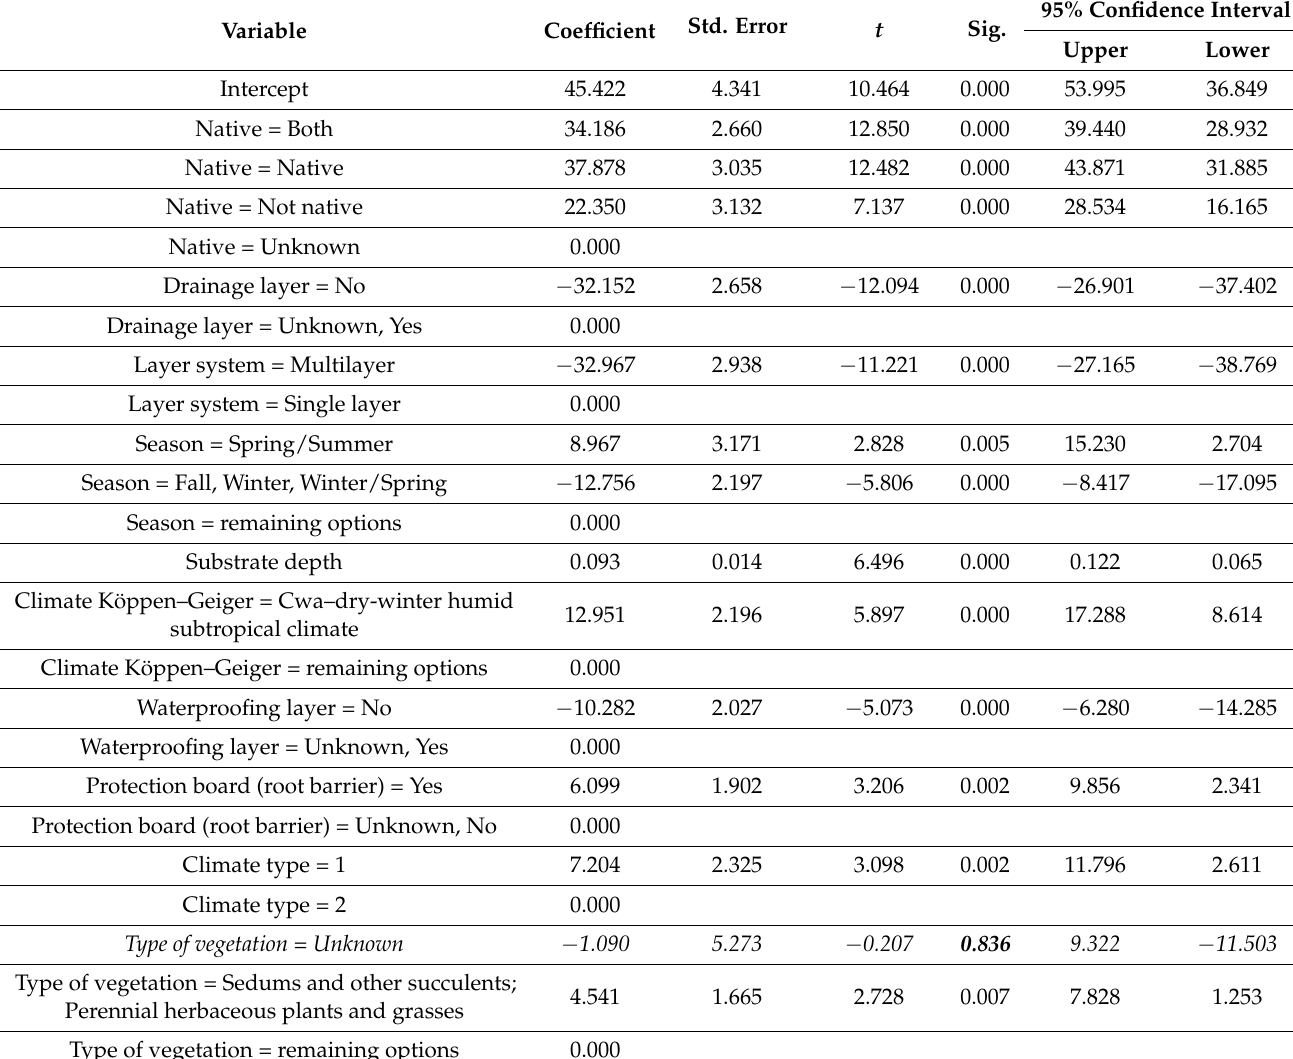
Table 9. Coefficients of the best regression